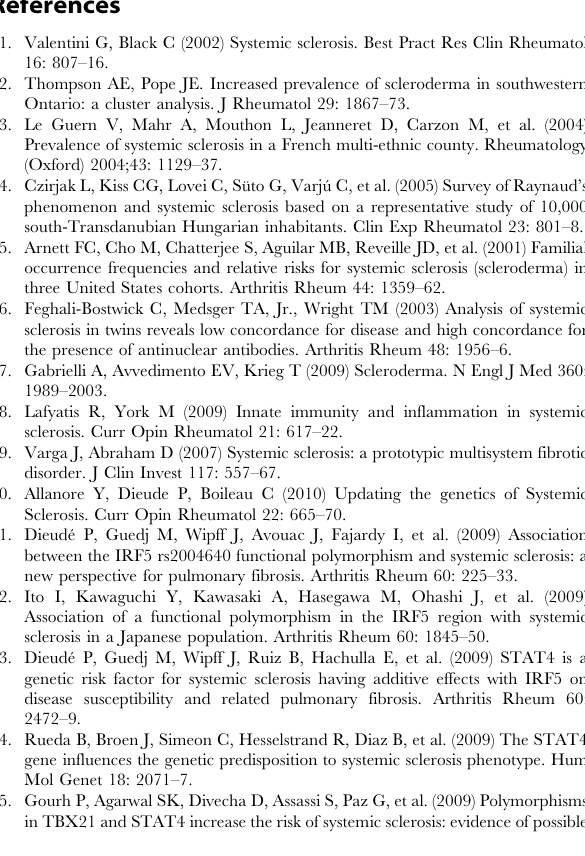
Figure 6. TNIP1 abrogates the profibrotic effects of proinflammatory cytokines on collagen synthesis by SSc fibroblatsts. (A,B) SSc dermal fibroblasts treated with recombinant TNFa or IL1 b and incubated 24 hours with TNIP1 displayed decreased mRNA levels for (A) COL1A1 (1.6 and 1.5-fold reduction, P =0.02 and 0.04, respectively) and (B) COL1A2 (1.7 and 1.8-fold reduction, P =0.02 and 0.009, respectively). No significant effect was observed in cells treated with recombinant IL6. (C) Collagen content in cell culture supernatants treated with TNFa or IL1 b was also reduced upon treatment with TNIP1 (1.8 and 2.3-fold reduction, P =0.04 and 0.03, respectively). * indicates a P , 0.05 vs. SSc fibroblasts treated with recombinant TNFa. ** indicates a P , 0.05 vs. SSc fibroblasts treated with recombinant IL1 b